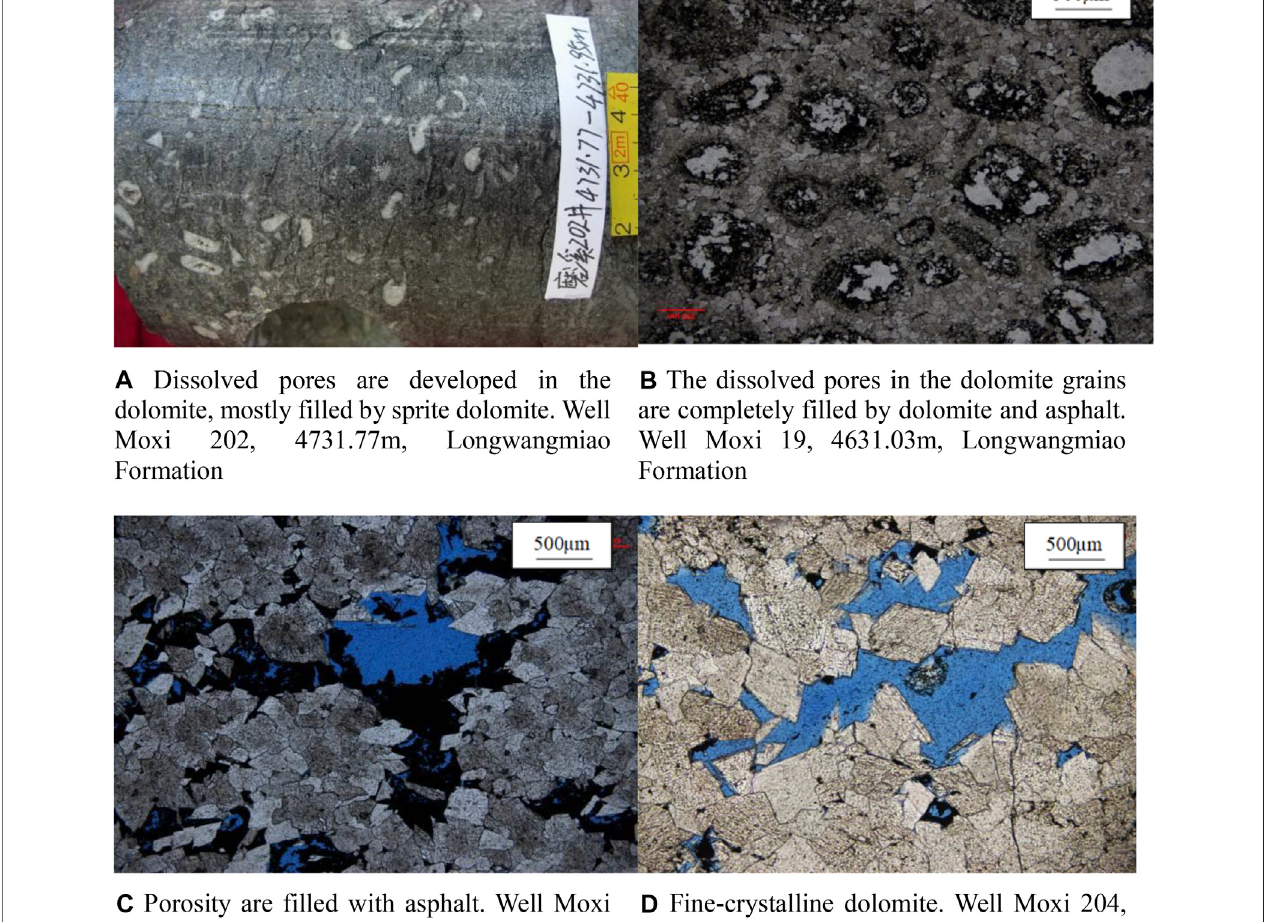
FIGURE 4 | Dissolution characteristics of Longwangmiao Formation in Sichuan Basin. (A) . Dissolved pores are developed in the dolomite, mostly fi lled by sprite dolomite.WellMoxi202,4,731.77 m,LongwangmiaoFormation, (B) .Thedissolvedporesinthedolomitegrainsarecompletely fi lledbydolomiteandasphalt.WellMoxi 19, 4,631.03 m, Longwangmiao Formation, (C) . Porosity are fi lled with asphalt. Well Moxi 202, 4,659.75 m, Longwangmiao Formation, (D) . Fine-crystalline dolomite. Well Moxi 204, 4,676.7 m, Longwangmiao Formation.